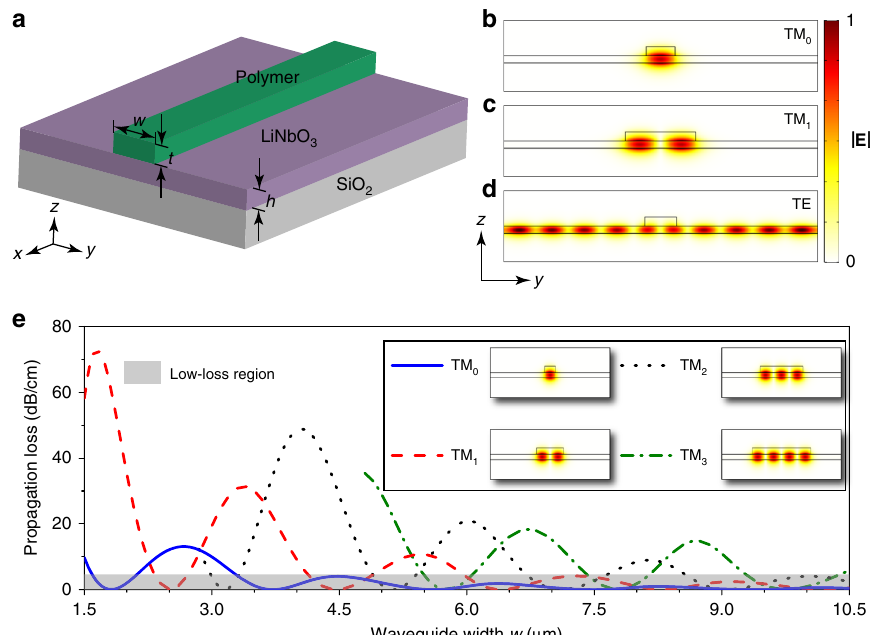
Fig. 1 Multimode BIC waveguide. a Waveguide structure composed of a low-refractive-index polymer stripe patterned on high-refractive-index LiNbO 3 layer, where w , t , and h are the waveguide width, the waveguide thickness, and the LiNbO 3 layer thickness, respectively. b – d Modal pro fi les | E | of the TM 0 bound mode ( b ), TM 1 bound mode ( c ), and TE continuous mode ( d ). e Simulated propagation loss of the TM 0 , TM 1 , TM 2 , and TM 3 modes in the waveguide as a function of the waveguide width w under the condition of t = 500 nm and h = 400 nm. For each mode, the BICs exist in the low-loss region as marked in